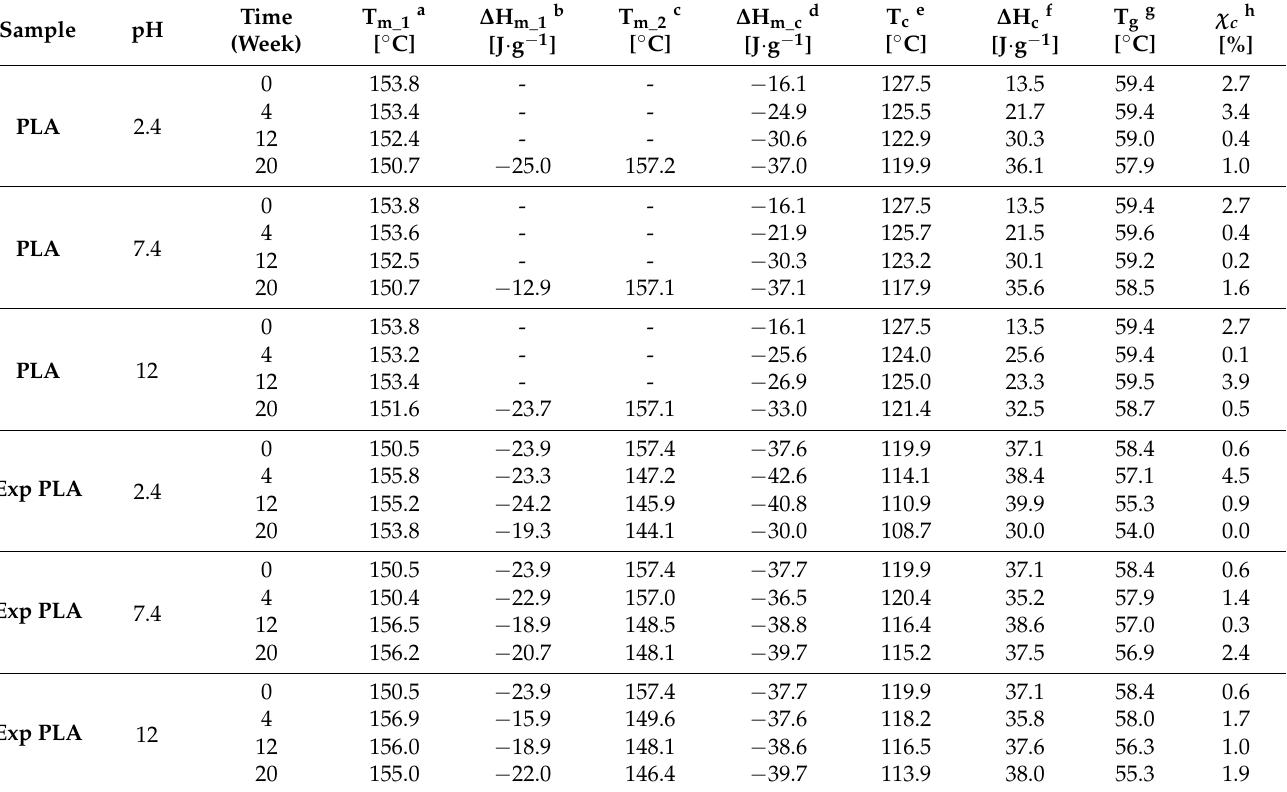
Table 2. Thermal properties of samples during abiotic hydrolysis experiments.